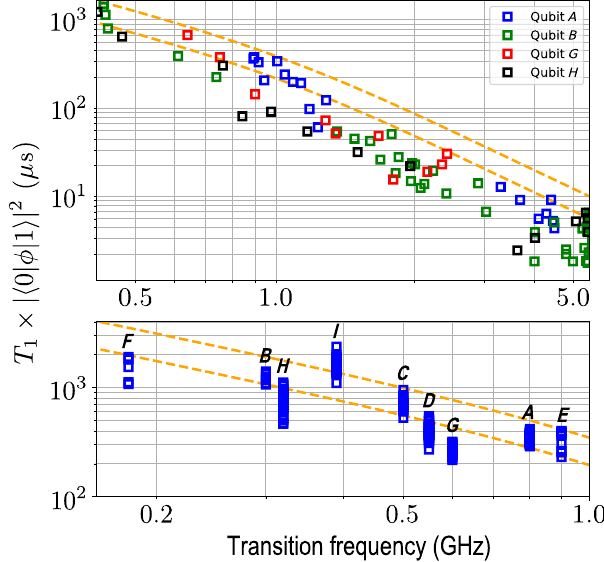
3. (Top) Normalized energy relaxation time (a quantity inversely proportional to the spectral density of noise coupled to the ϕ variable) as a function of the qubit transition frequency measured by tuning flux in devices A , B , G , H . (Bottom) Same quantity, including repeated in time measurements, for all devices A – I biased at their half-integer flux sweet spots. Dashed lines represent a dielectric loss theory (see